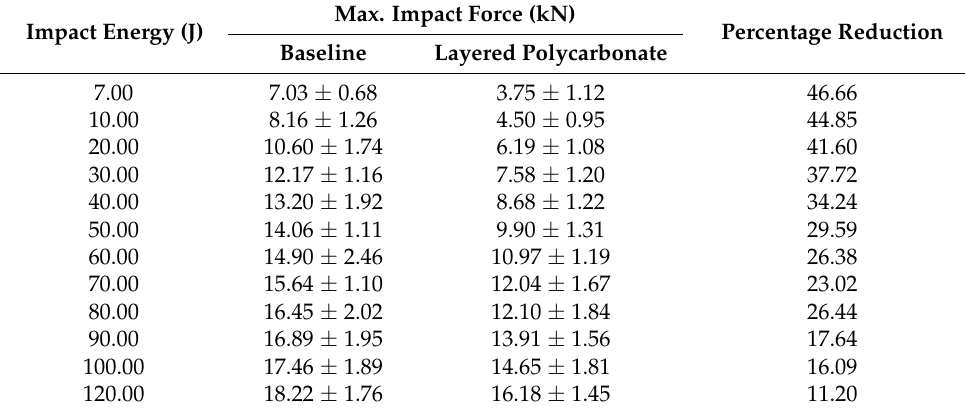
Table 2. Maximum impact force for baseline and layered Polycarbonate